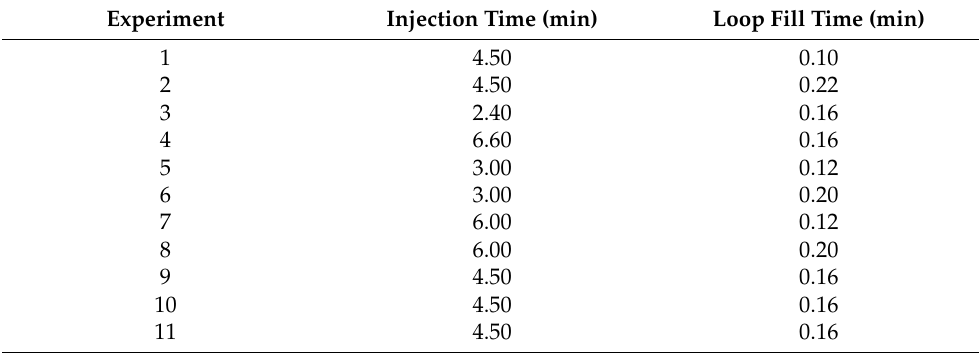
Table 2. Experiment matrix for CCD.